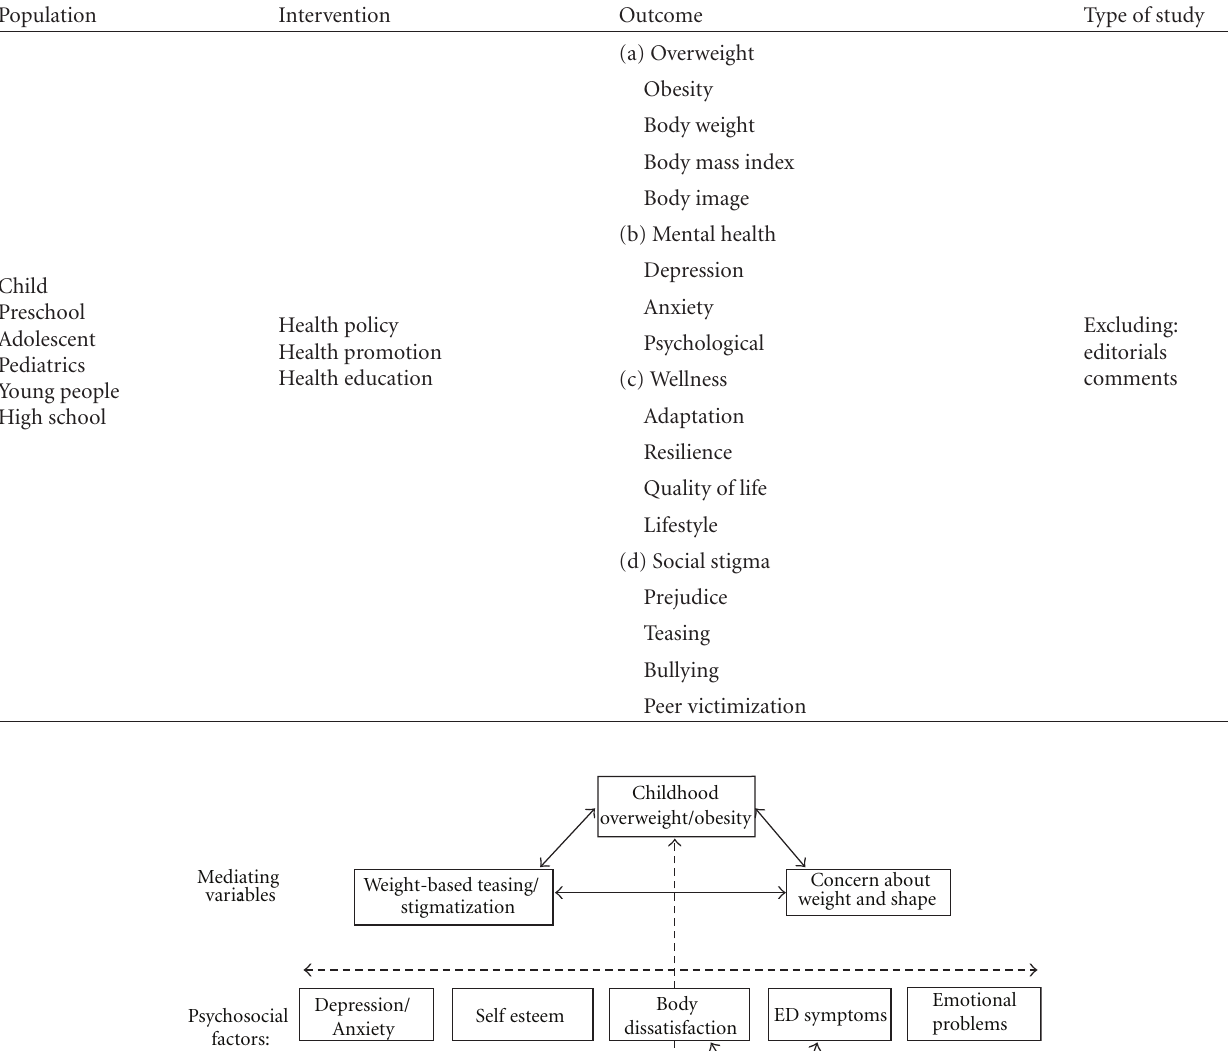
Table 1: Search terms used.